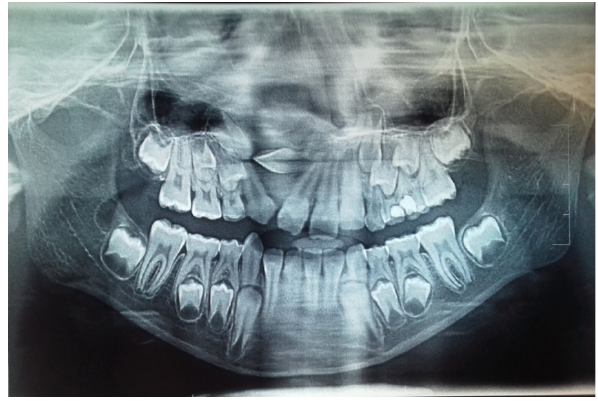
Figure 1: DPT radiograph; before preoperative orthodontic